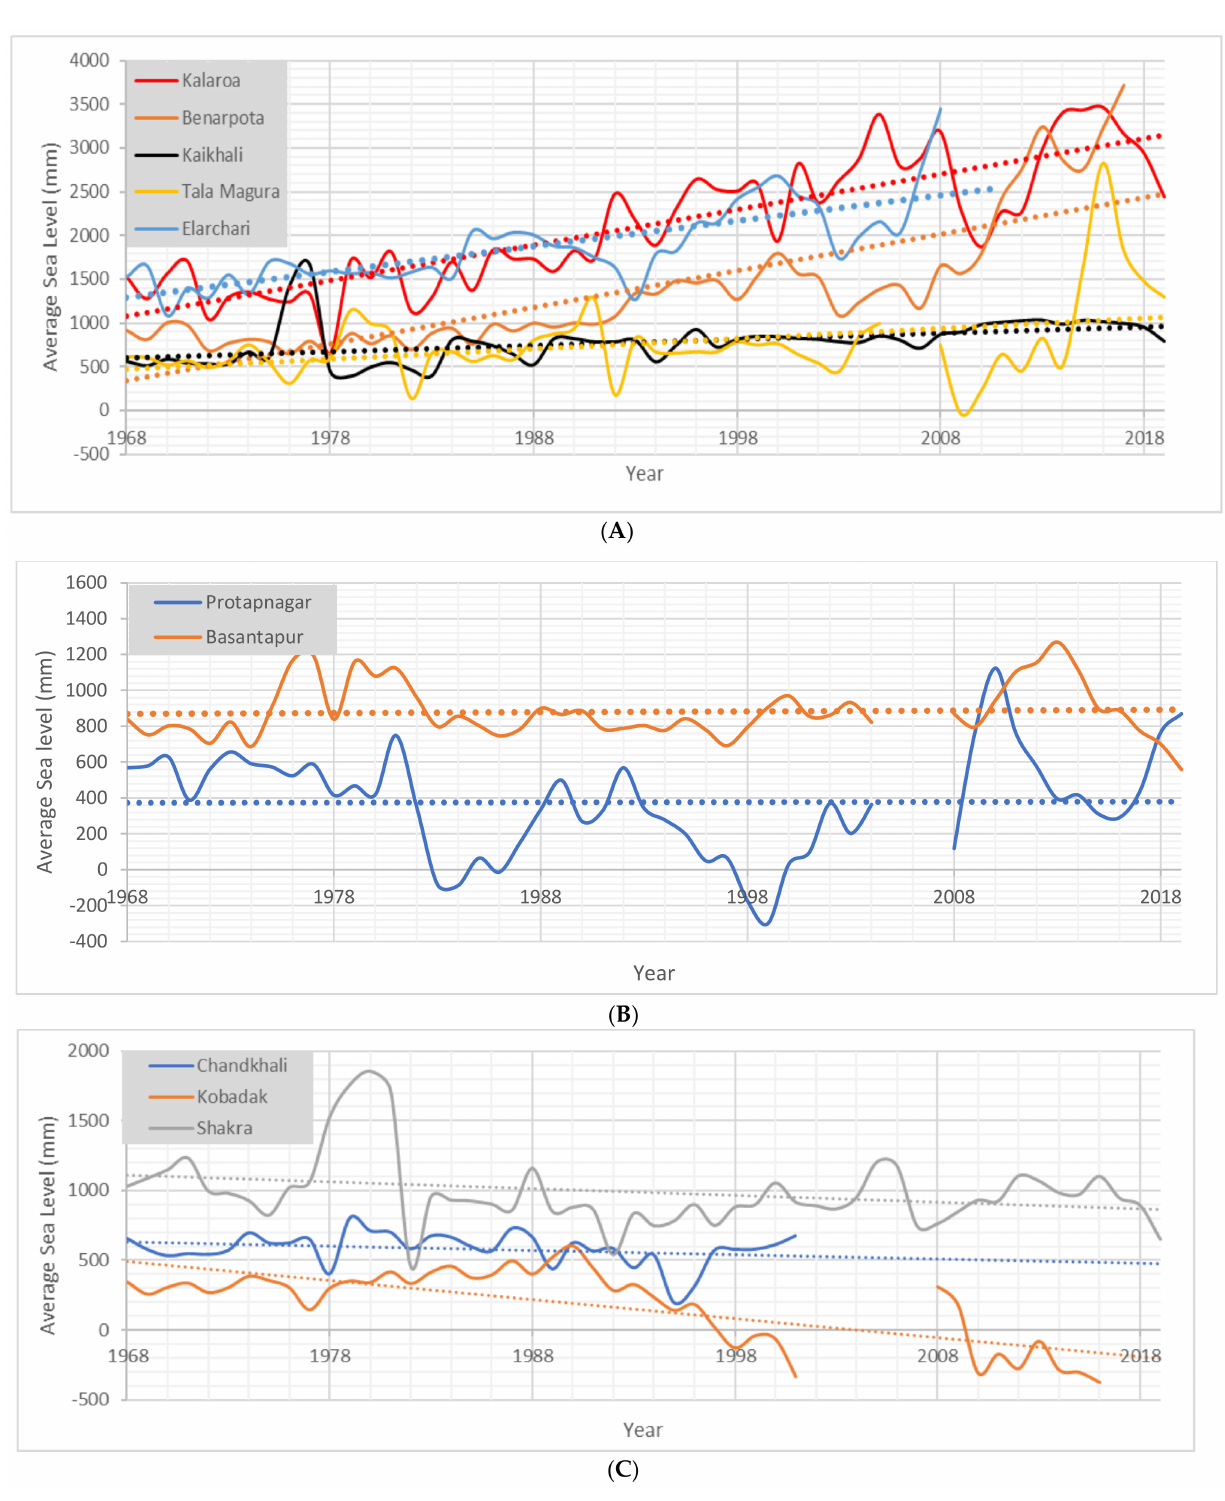
Figure 3. The historical records of deltaic regions within the study area; the trend line indicates the trend of sea level. Stations with increasing sea level ( A ); no significant change ( B ); and decreasing sea levels ( C ). These patterns show a lot of variation in sea level rise, which can be attributed to the highly dynamic geomorphological processes of deltaic regions (Data Source: BWDB,